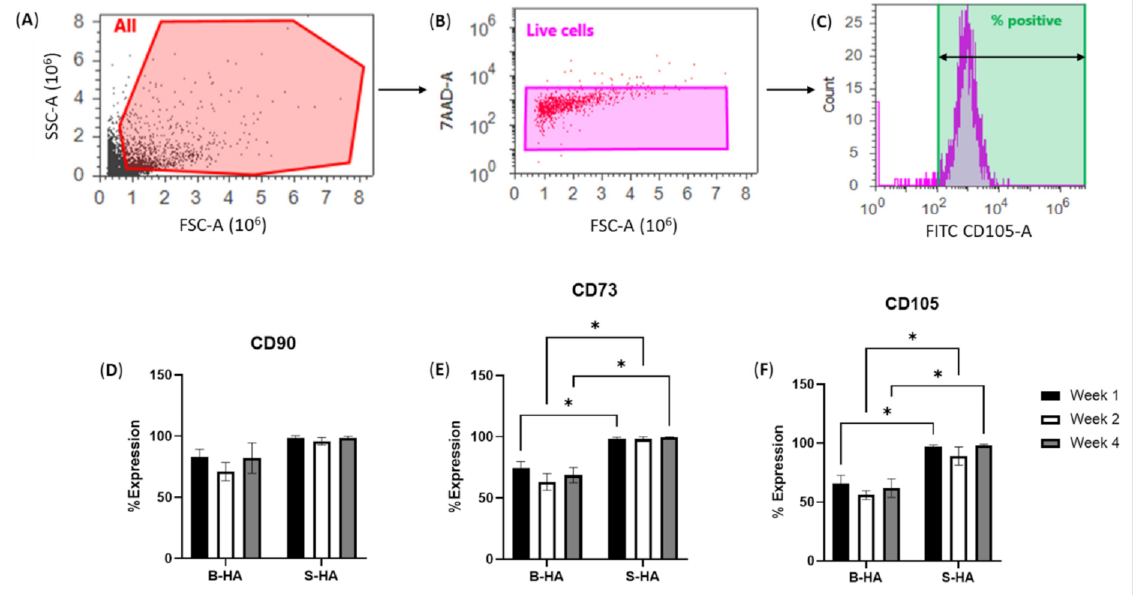
Figure 3. Phenotypic analysis of cMSCs after extraction from B-HA and S-HA scaffolds. ( A – C ) Gating strategy from all events ( A ) to gating on live 7-AAD-negative cells ( B ) and calculation the percentage of marker-positive cells based on histogram ( C ). ( D – F ) Percentage expression of MSC markers on the extracted cells from both scaffolds at week 1, week 2 and week 4 for CD90 ( D ), CD73 ( E ) and CD105 ( F ). Results are shown as mean with standard error of mean for n = 3 cMSCs. * p <